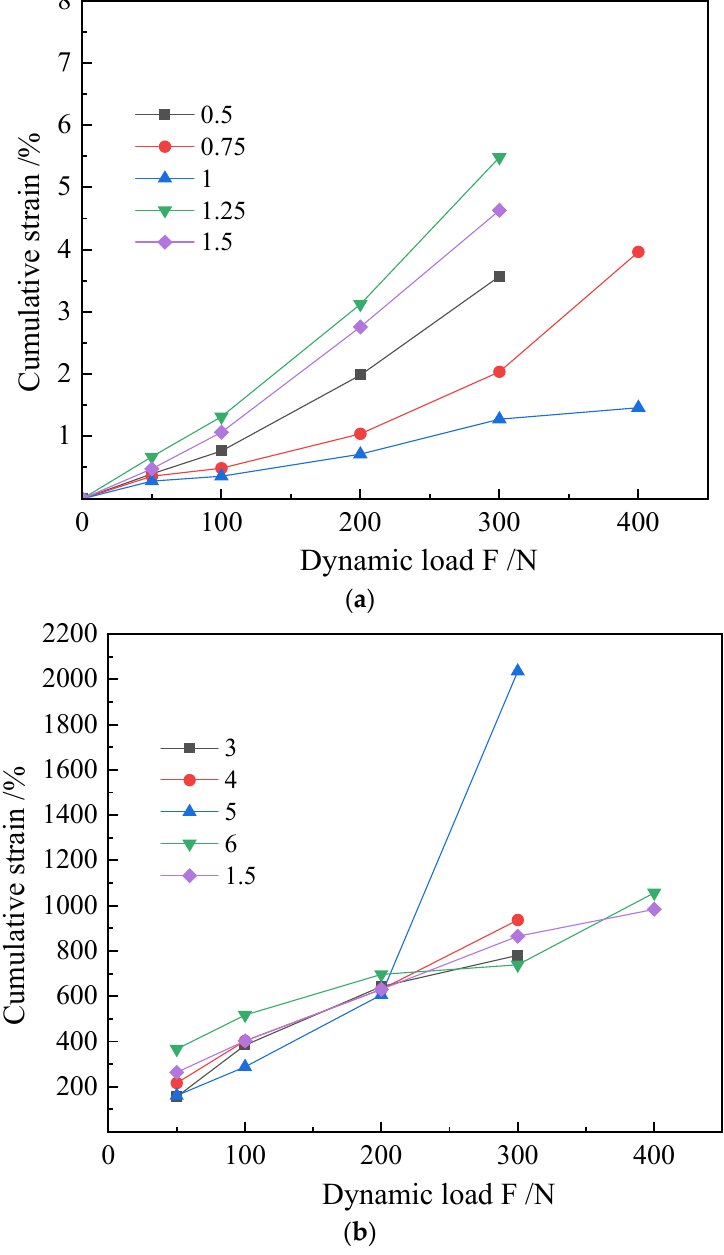
Figure 7. L scheme sample. ( a ) Cumulative strain curve, ( b ) resilience modulus Ed and dynamic load curve.